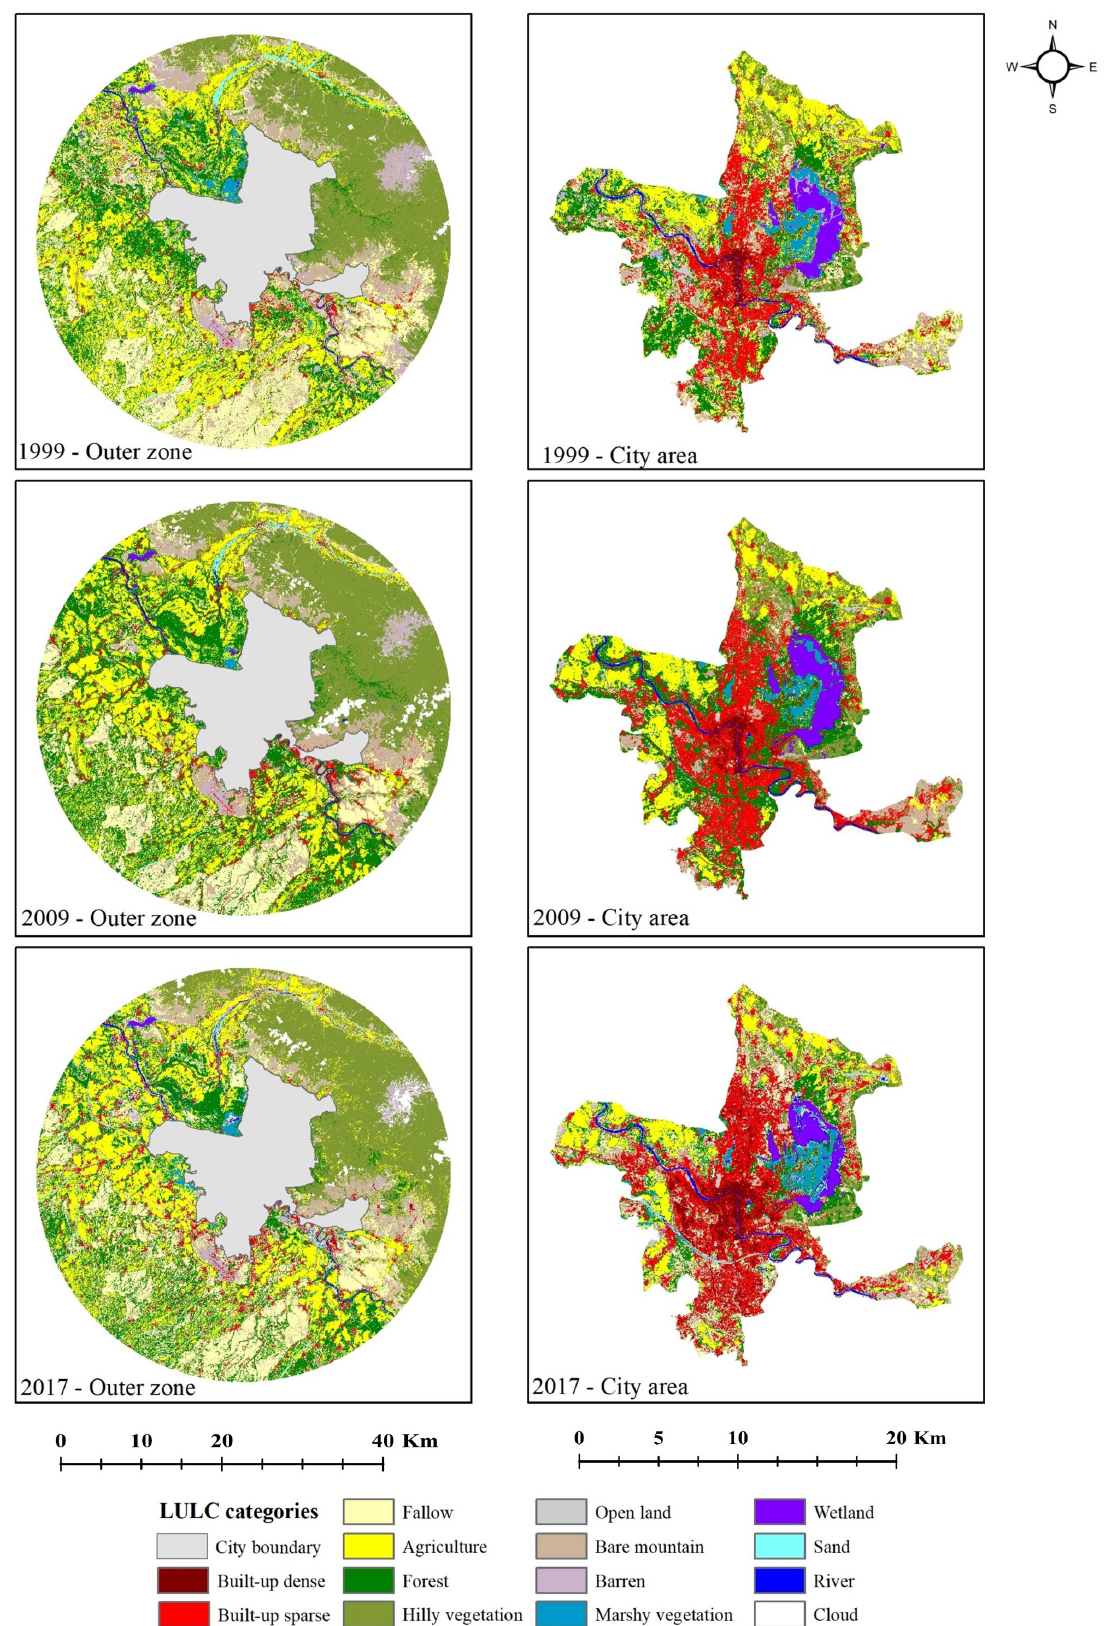
Figure 3. LULC changes in outer zone (OZ) and city area (CA) of